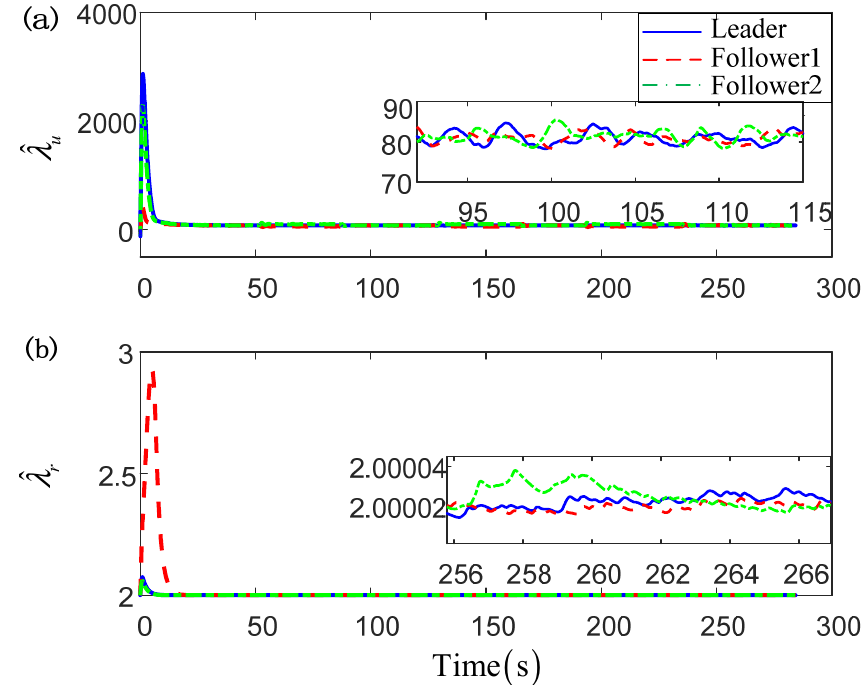
Figure 6. The control input for follower 1: ( a ) control input of the propeller; ( b ) control input of the rudder.